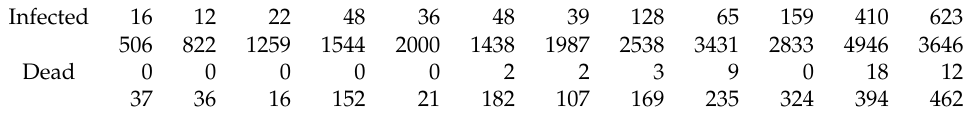
Table 2. Data record of infected people and the dead of the first 24 days of the Covid-19 epidemics in Spain (natural order from left to right). Data-source: https://github.com/datadista/datasets/tree/ master/COVID%2019.